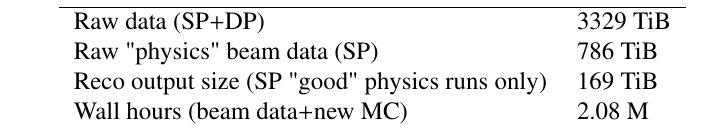
Table 1. Statistics on the most recent ProtoDUNE-SP reprocessing campaign, August-October 2019. "Physics" data is defined as data taken with beam, as opposed to cosmic ray or DAQ test data. "Good" runs are those runs taken with beam when the DAQ system and detector were fully